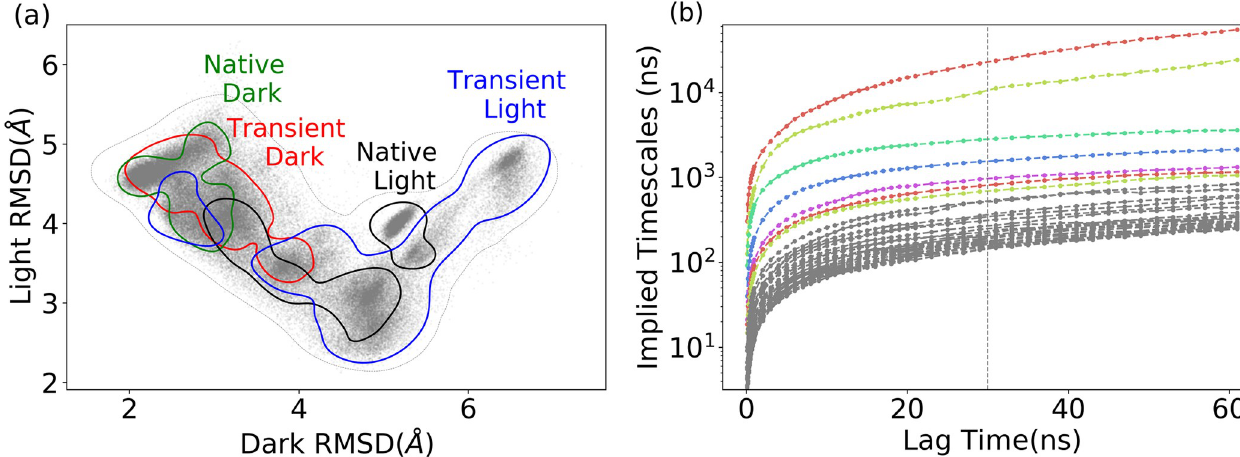
Fig 2. Molecular dynamics simulations of VVD protein with four different configurations, native dark and native light configurations, and transient dark and transient light configurations. (a) 2D-RMSD plot of the simulations with different configurations with reference to the native dark and light structures, respectively, (each contour in different color represents the samplings from three trajectories with the same configuration); (b) Estimated relaxation timescale based on transition probabilities among different microstates regarding with the different lag time as interval for